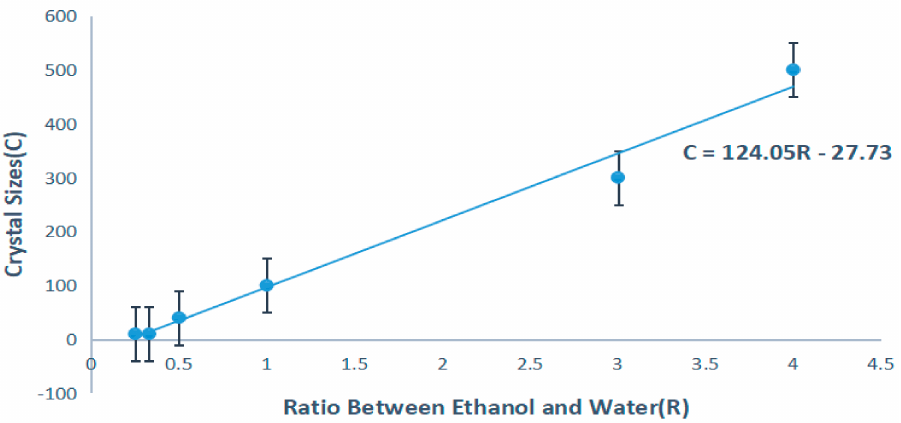
Figure 4. The linear relationship between the volume ratio of ethanol to water and crystal